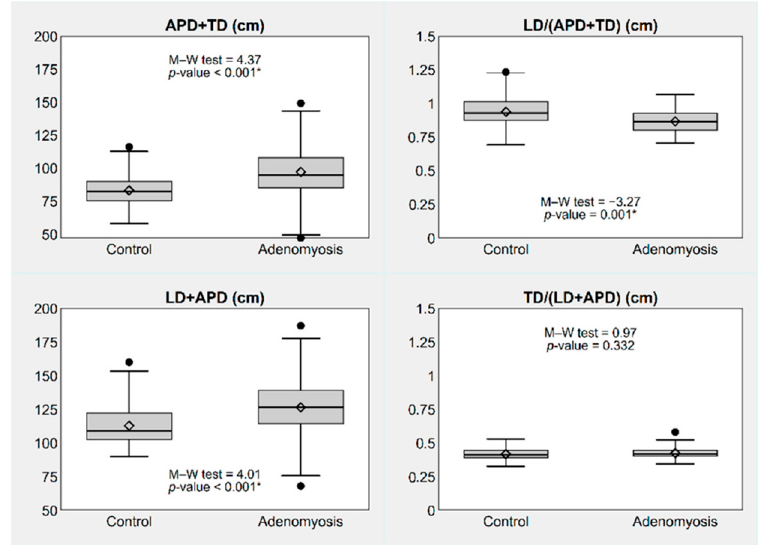
Figure 4. Box plots showing diameter sum and complex diameter ratios of the uterus, by presence or absence of adenomyosis. * p -value ≤ 0.05. Notes: The box represents the interquartile range (IQR), i.e., the distance between the 1st and the 3rd quartile (Q1, Q3); the bar and diamond inside the box represent the median and the mean, respectively; the whiskers represent the lower and upper adjacent values, i.e., the lowest observation ≥ Q1 − 1.5 × IQR and the largest observation ≤ Q3 + 1.5 × IQR; the circles represent the individual values observed outside the whiskers (outliers). Abbreviations: LD, longitudinal diameter; APD, antero-posterior diameter; TD, transverse diameter.